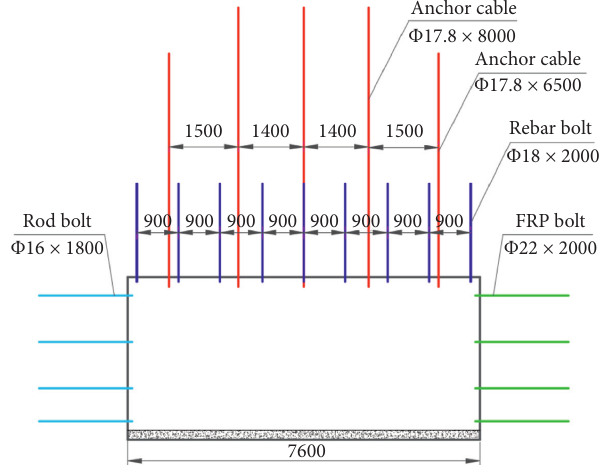
Figure 3: The supporting section of the open-off